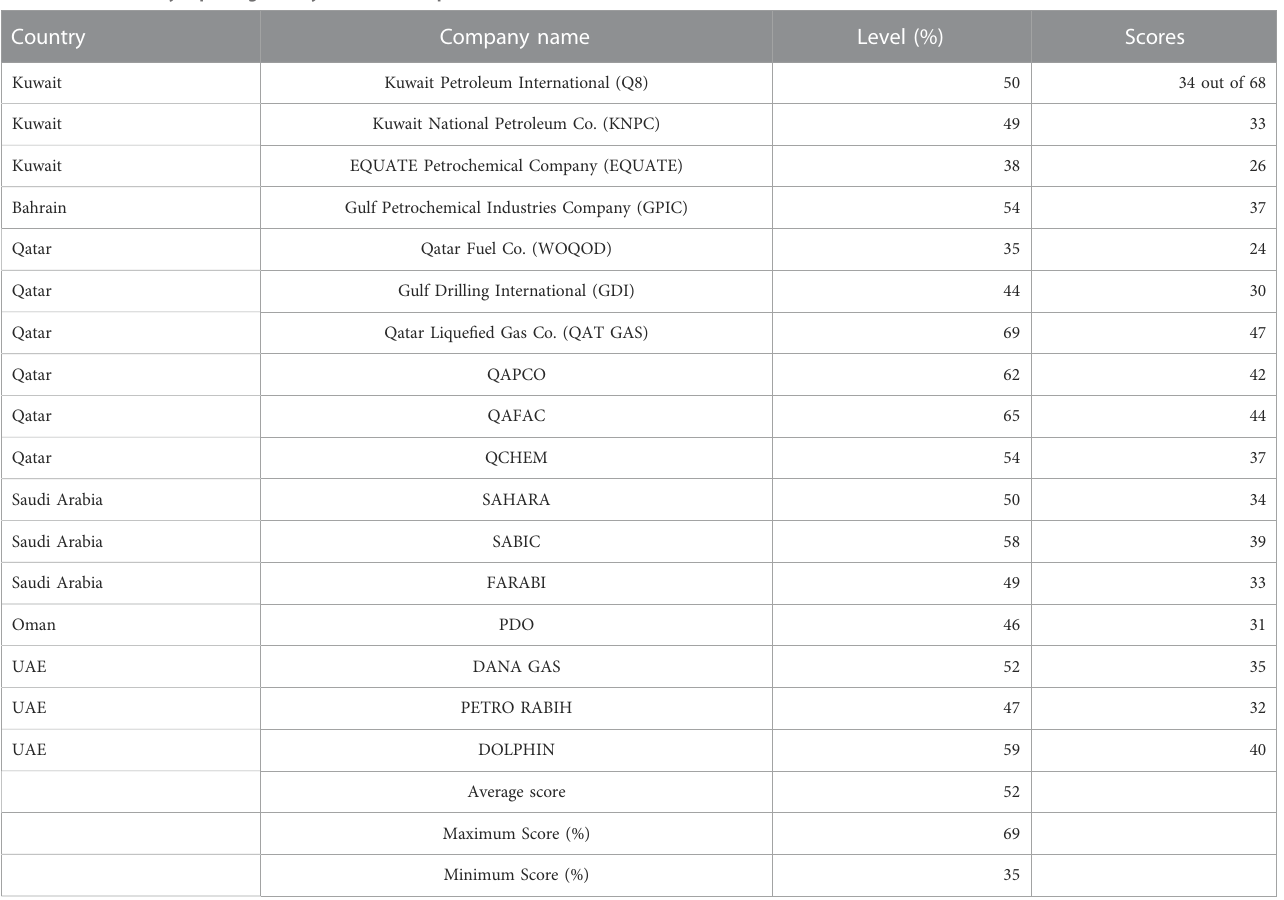
TABLE 1 Sustainability reporting Quality based on